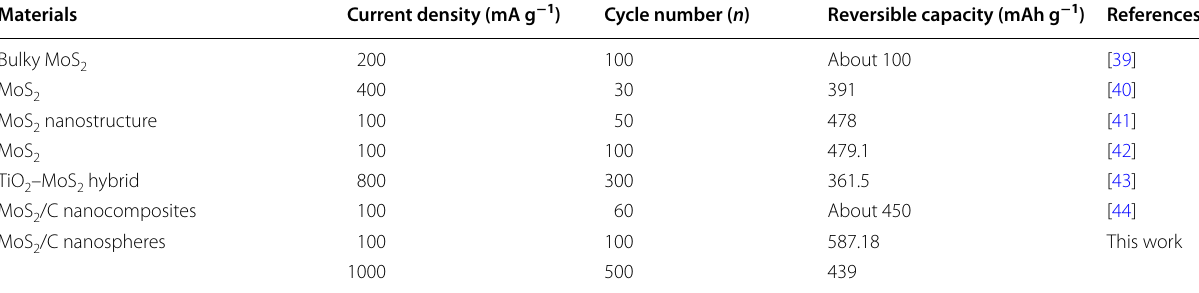
Table 1 Comparison of the electrochemical properties of MoS2 Materials